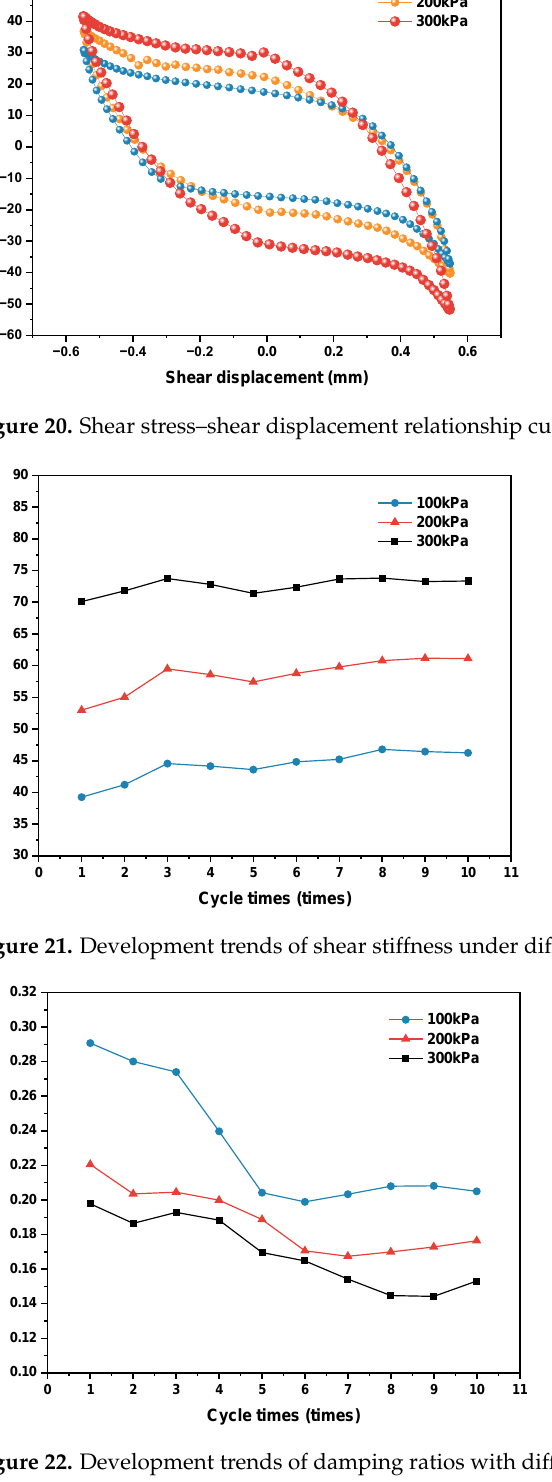
Figure 22. Development trends of damping ratios with different vertical stresses.